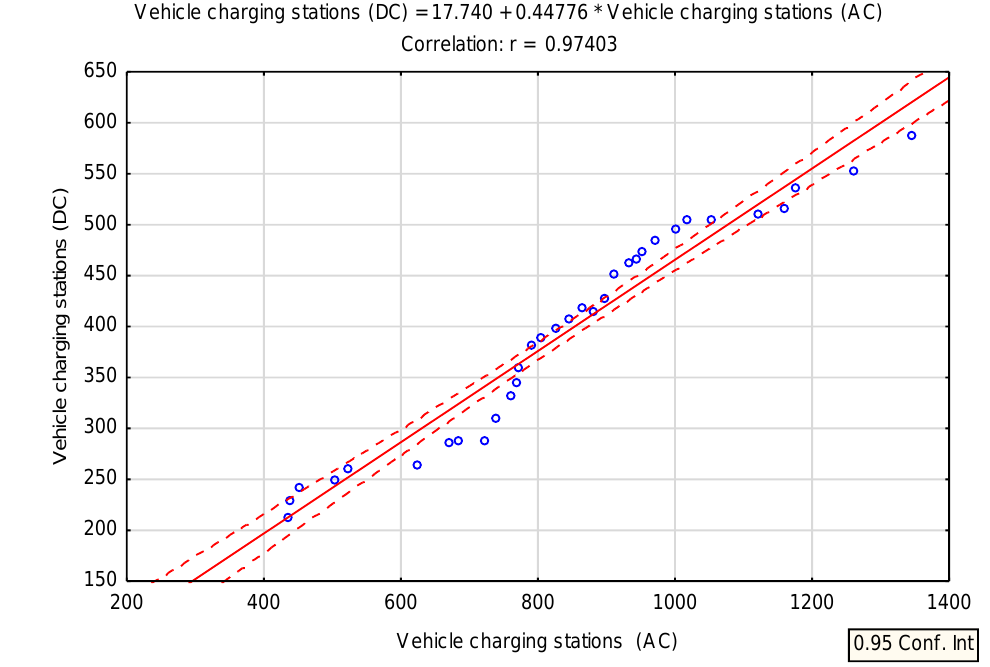
Figure 11. The number of DC charging stations and AC charging stations on the Polish market in the years 2019–2021 in relation to the linear correlation-scatterplot. Table 4. Correlation relationship of AC and DC variables for p < 0.05000, N = 33. Variable Y-Vehicle Charging Stations—DC